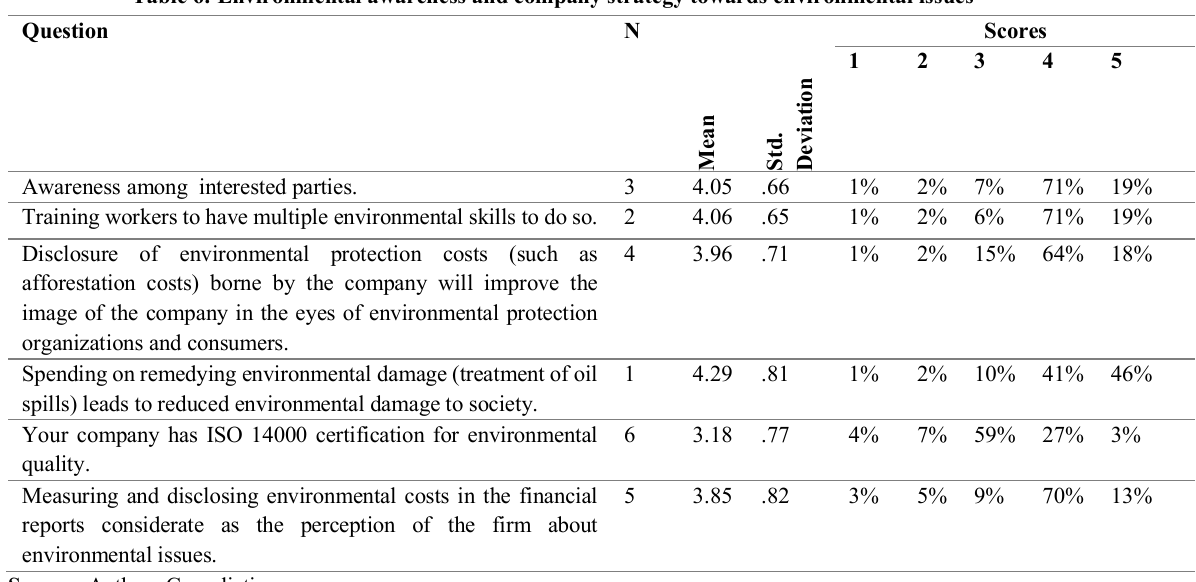
Table 6: Environmental awareness and company strategy towards environmental issues Question N